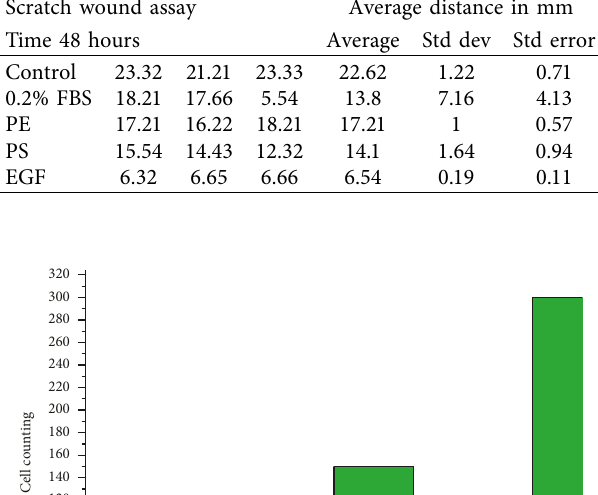
Table 4: Scratch wound assay 48 hours. Scratch wound assay Average distance in mm